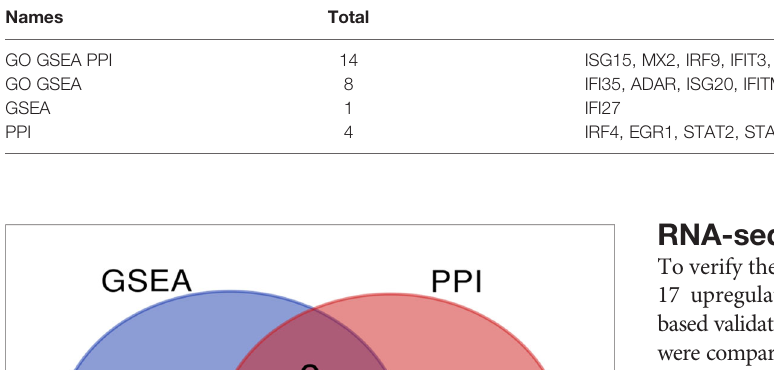
TABLE 3 | Overlap of type I IFN signaling pathway-related genes among GO, GSEA, and PPI analysis results. Names